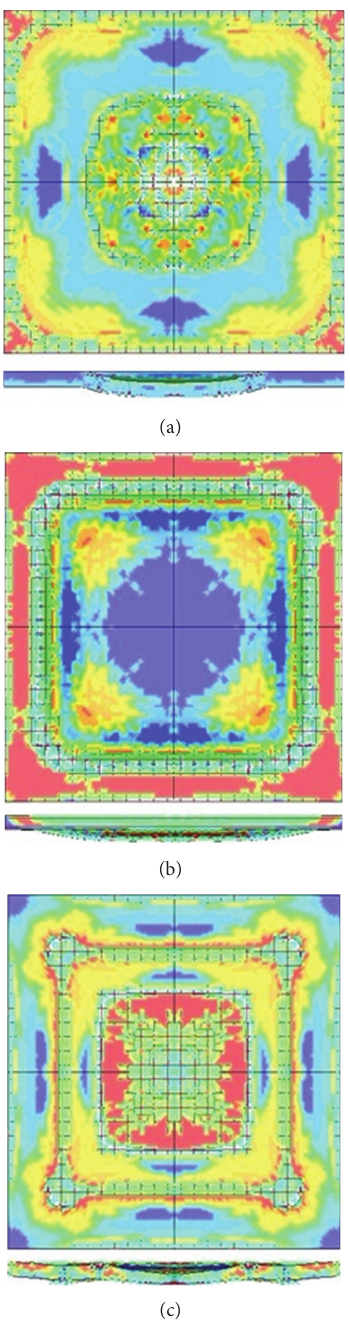
Figure 8: Failure modes: (a) flexural failure, (b) direct-shear failure, and (c) flexural-shear